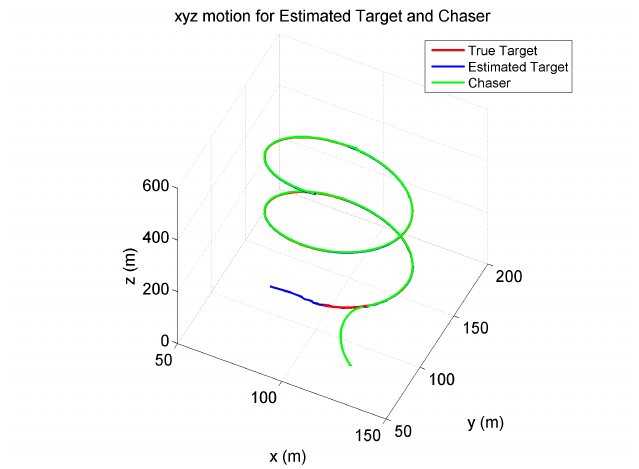
Figure 16. Chaser trajectory while tracking the estimated target (Case